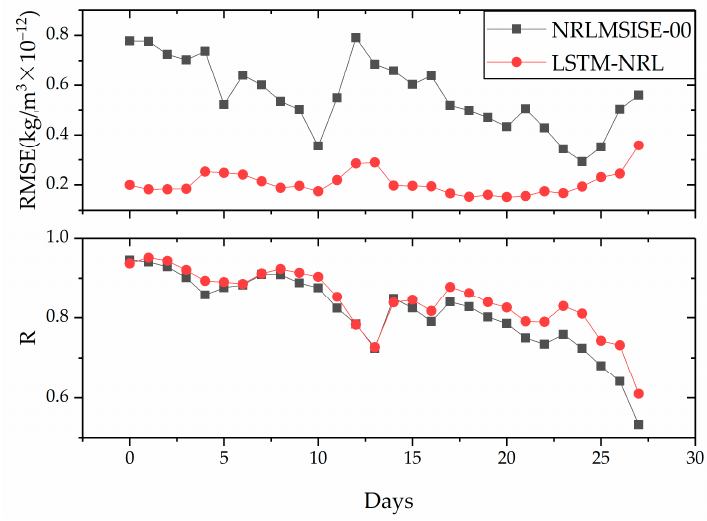
Figure 4. The daily RMSE and R over a month of Test 2.